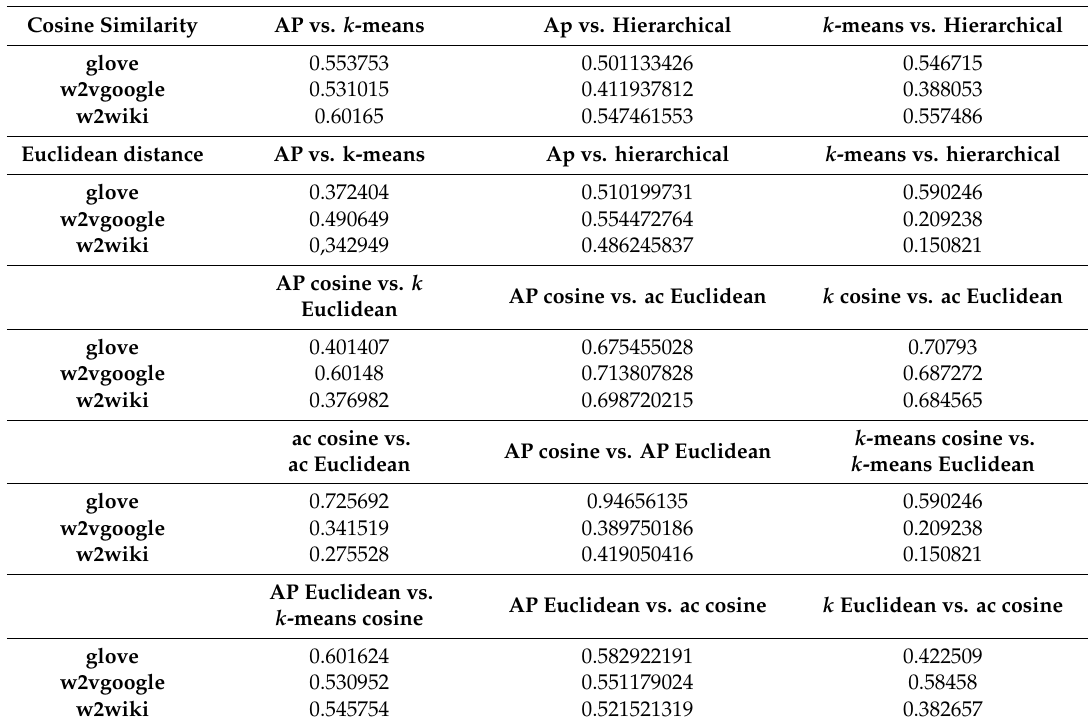
Table A1. Sørensen–Dice (SD) coe ffi cients for word embedding models and clustering algorithms, on 1